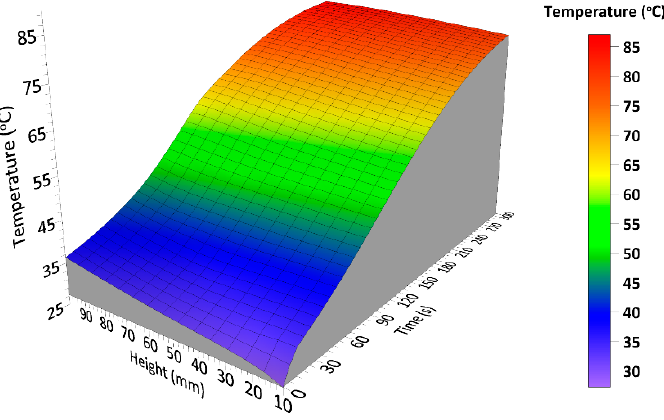
Figure 4. Cumulative graph for the PU_10PFA foaming